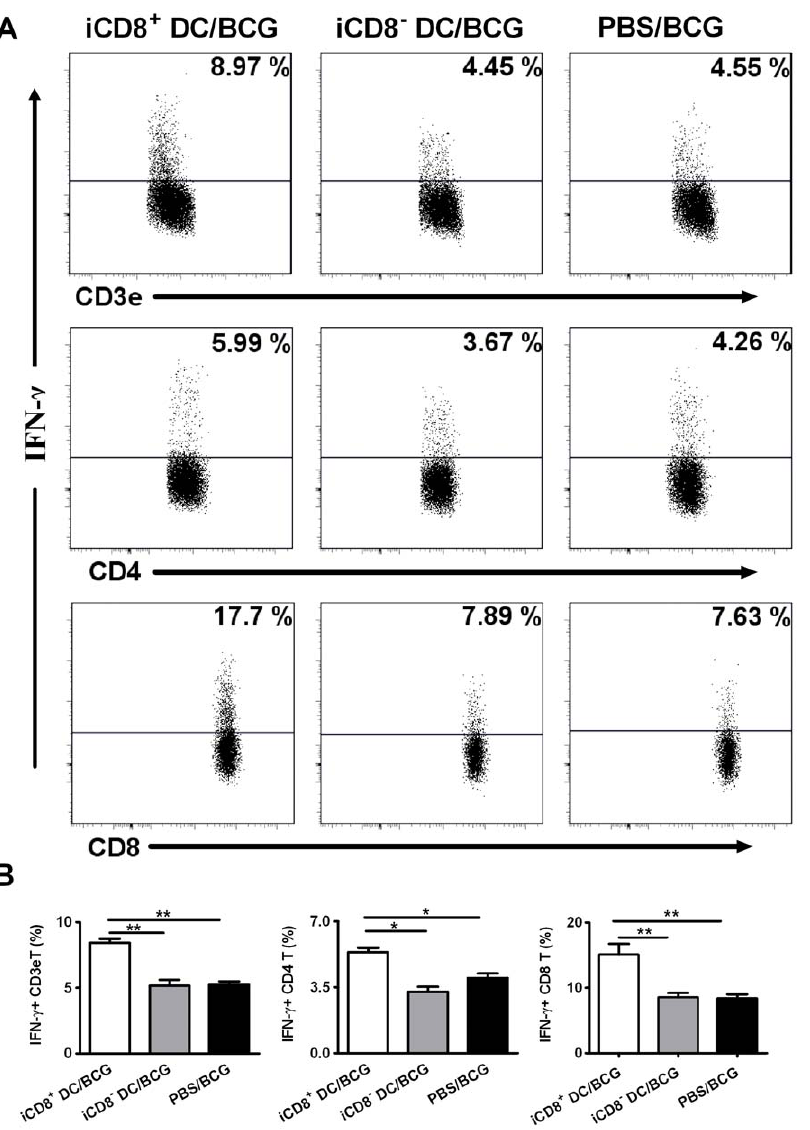
Figure 8. Intranasal adoptive transfer of iCD8 + DC, but not iCD8 2 DC, enhanced IFN- c production by T cell. Mice were adoptively transferred i.n. with iCD8 + DC or iCD8 2 DC subsets followed by the challenge with BCG through i.n route as described in Materials and Methods. Draining lymph nodes was isolated aseptically and single cell suspension was prepared in cold staining buffer. Cells were co-stained with FITC-anti CD3 e , PE-anti CD4, PerCP-anti CD8 Abs and stained for intracellular IFN- c using allophycocyanin -conjugated anti-IFN c Ab as described in Materials and Methods. Cells were gated on CD3 e + T cells, CD3 e + CD4 + T cell and CD3 e + CD8 + T cell respectively and the percentage of positive cells for IFN- c is indicated in upper right corner (A). Pooled data in each group are shown as mean 6 SD (B). One representative experiment of two independent experiments is shown. *p , 0.05; **, p , 0.01.